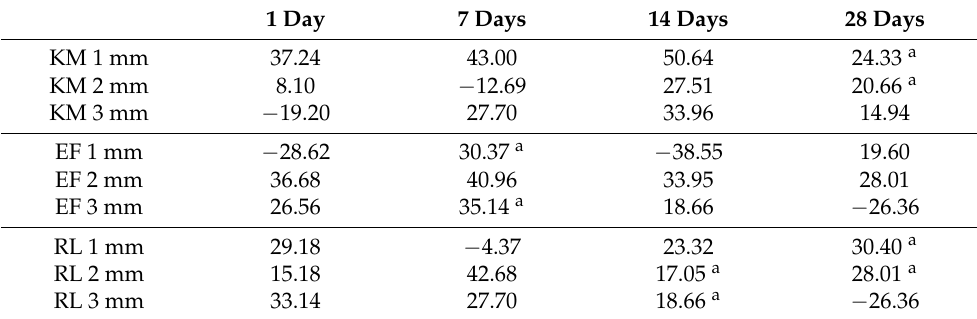
Table 4. Percentage gain in Ca/P ratio (mol), calculated from EDX results, in dentin by materials, times, and thickness compared to demineralized